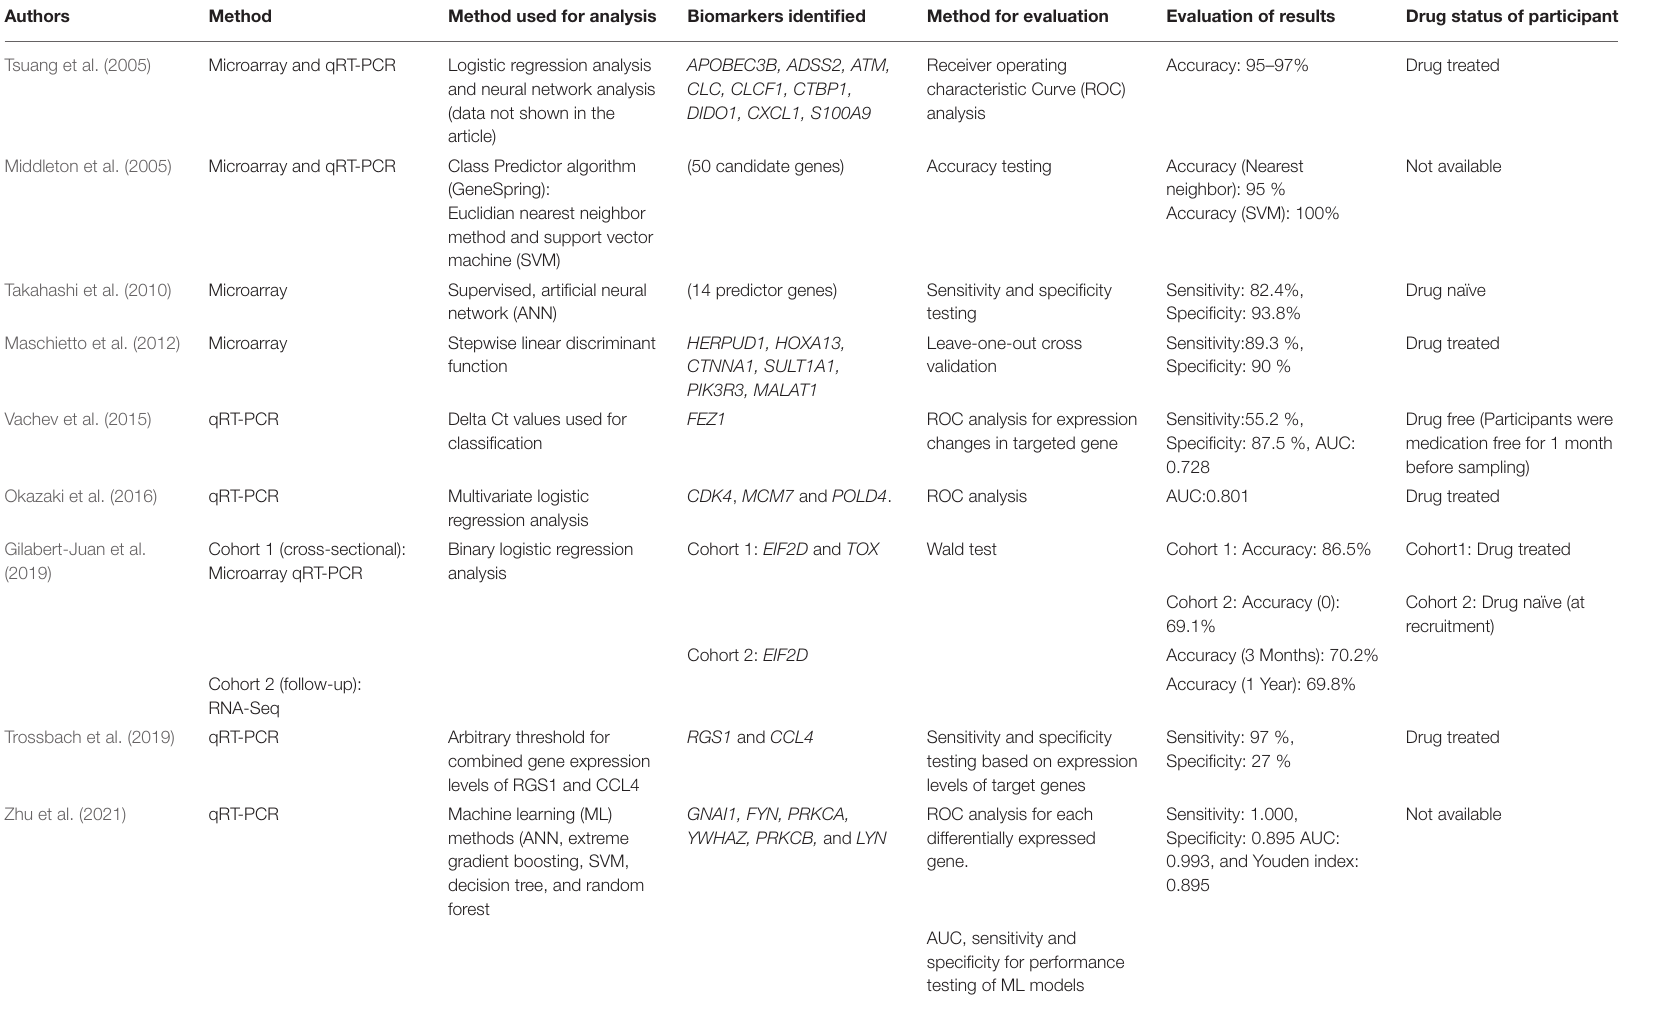
TABLE 4 | Studies on identification and evaluation of potential